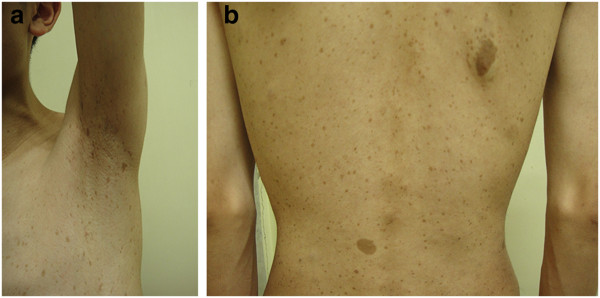
The special signs of the patient. Axillary freckling (a) and multiple caféau-lait spots (b) spread over the skin of the trunk.